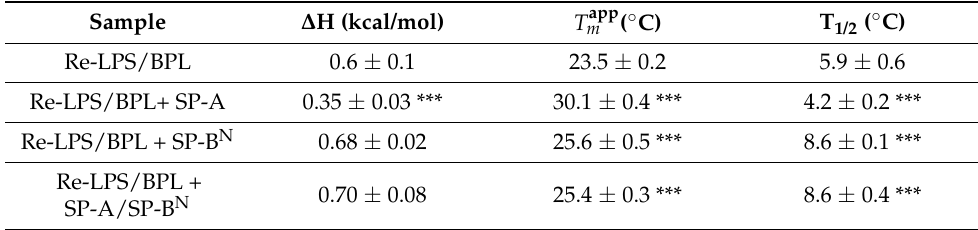
Table 2. The effect of SP-A 154 nM (100 µ g/mL) and SP-B N 1.25 µ M (10 µ g/mL), alone or mixed at a SP-A/SP-B N molar ratio of 1:8, on the apparent phase transition temperature ( T app m ), enthalpy ( ∆ H), and relative cooperativity (T 1/2 ) of multilamellar vesicles composed of Re-LPS/BPL (molar ratio of 1.2:1). Data shown are the mean ± SD of three independent experiments. A p -value < 0.001 was obtained for the overall one-way ANOVA (Bonferroni-corrected p -value: *** p < 0.001 when compared to control multilamellar vesicles of